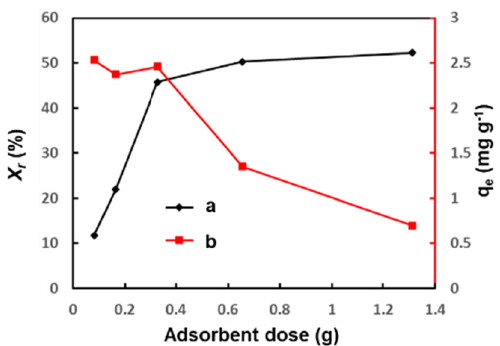
Figure 3: ATR - FTIR spectra of pollen ( a ) and pollen@FePO 4 ( b ) .